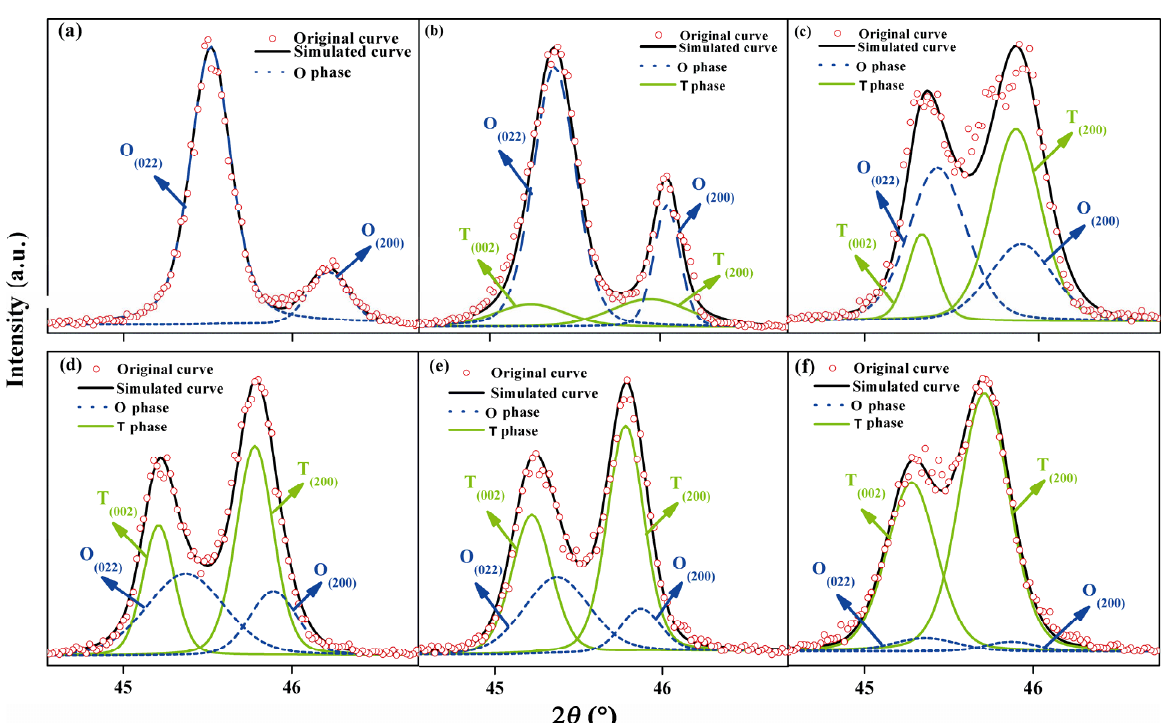
Fig. 3 Amplified XRD patterns simulated by Gaussian–Lorentzian curve-fitting method: (a) x = 0, (b) x = 0.01, (c) x = 0.03, (d) x = 0.04, (e) x = 0.05, (f) x =